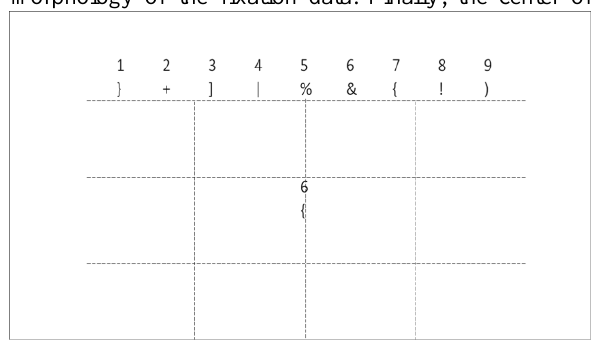
Fig. 4 Division of QA for evaluation of performance index in version 3